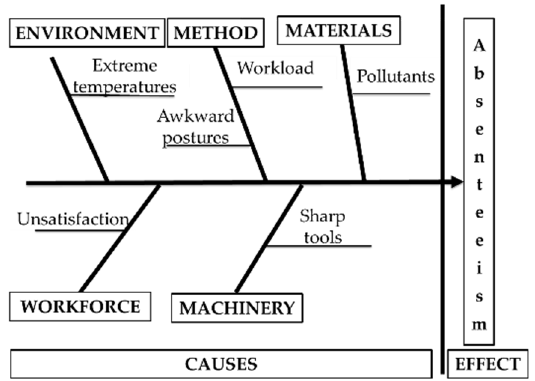
Figure 3. Ishikawa diagram to illustrate the causes of an absenteeism problem.